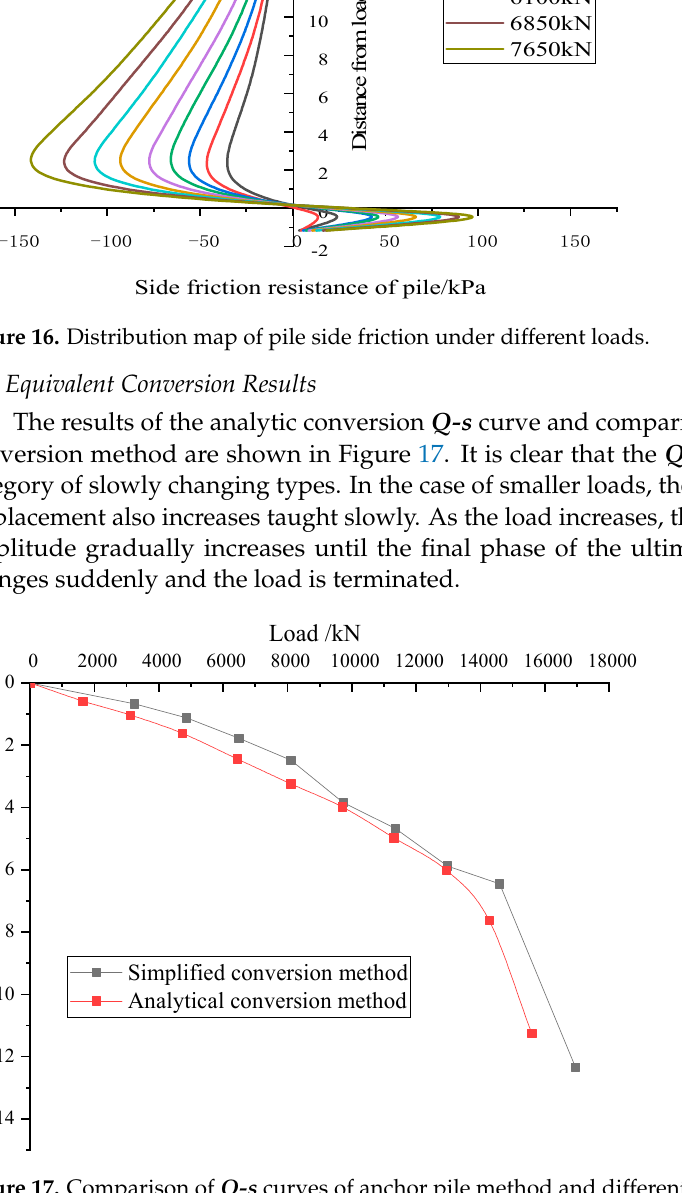
Figure 15. Axial force distribution under different loads. Figure 16. Distribution map of pile side friction under different loads.